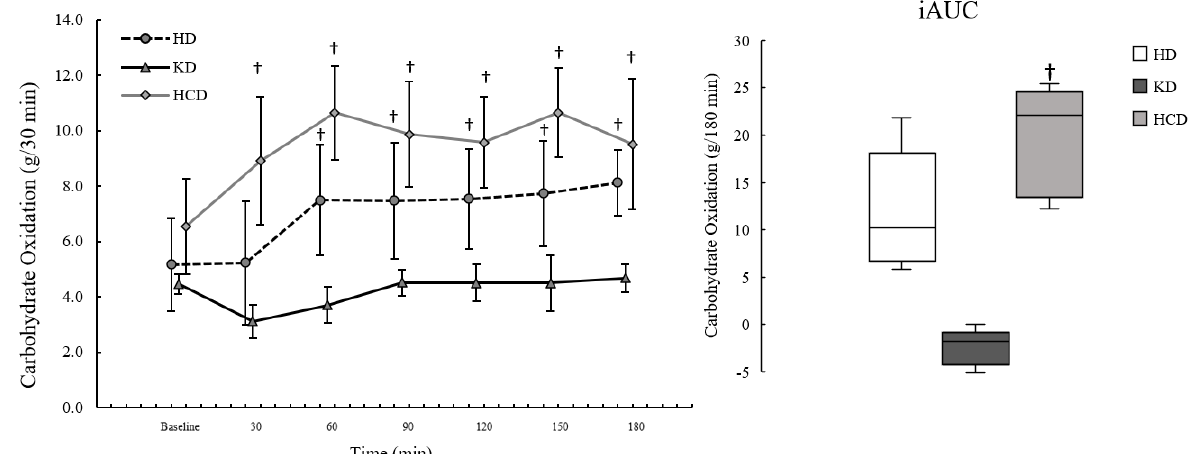
Figure 4. Carbohydrate oxidation (CarbOx) following a ketogenic meal (KD), a high-carbohydrate meal (HCD), and a habitual meal (HD). Each point on the line graph is plotted as mean and standard error. The boxplots represent the incremental area under the curve (iAUC) where the line within each box represents the 50th percentile; the upper and lower limits of each box represent the 25th and 75th percentile; and the upper and lower error bars representing the 10th and 90th percentile. CarbOx was significantly higher at all timepoints following the HCD meal (all p < 0.050) and at all timepoints other than 30 min ( p = 0.298) for the HD meal when compared to the KD meal . There were no differences in postprandial CarbOx between the HCD meal and HD meal . CarbOx iAUC was significantly lower after the KD meal compared to the HCD meal ( p = 0.005). HD: habitual diet meal; KD: ketogenic diet meal; HCD: high-carbohydrate meal. † = significantly different from the KD at p ≤ 0.050. * = significantly different from the HCD at p ≤